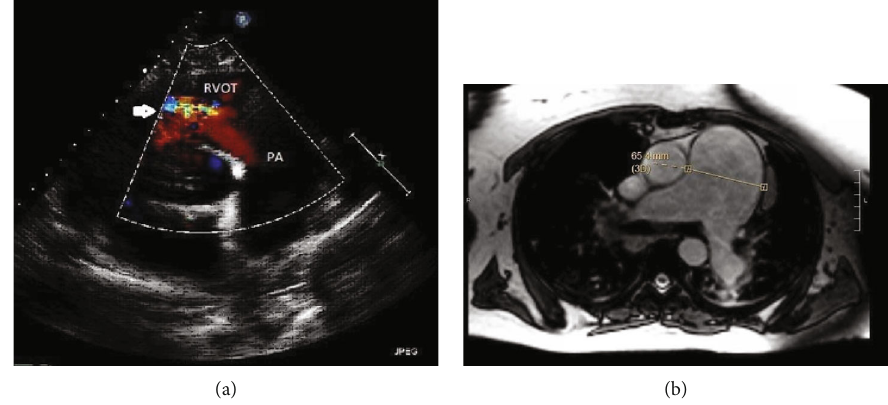
Figure 2: (a) Transthoracic echocardiogram parasternal short axis color Doppler showing severe pulmonic regurgitation (white arrow) and dilated pulmonary artery. (b) Cardiac MRI showing marked aneurysmal enlargement of the main